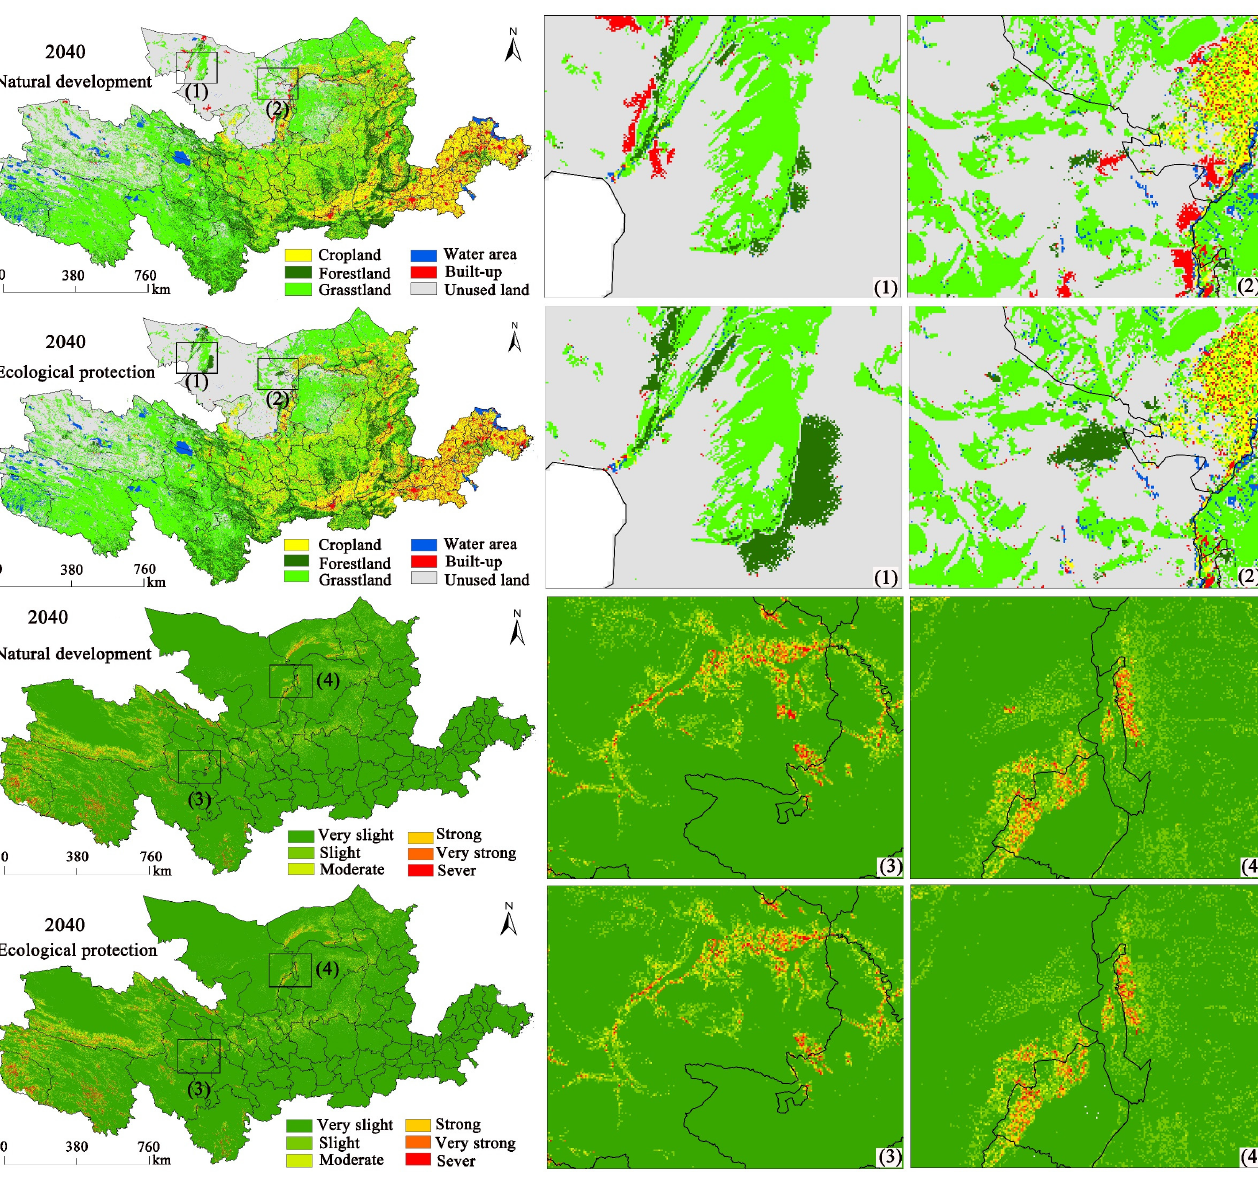
Figure 7. Maps of SE and land usage under natural development and ecological protection in 2040. (1), (2), (3) and (4) represent randomly selected areas of significant change.